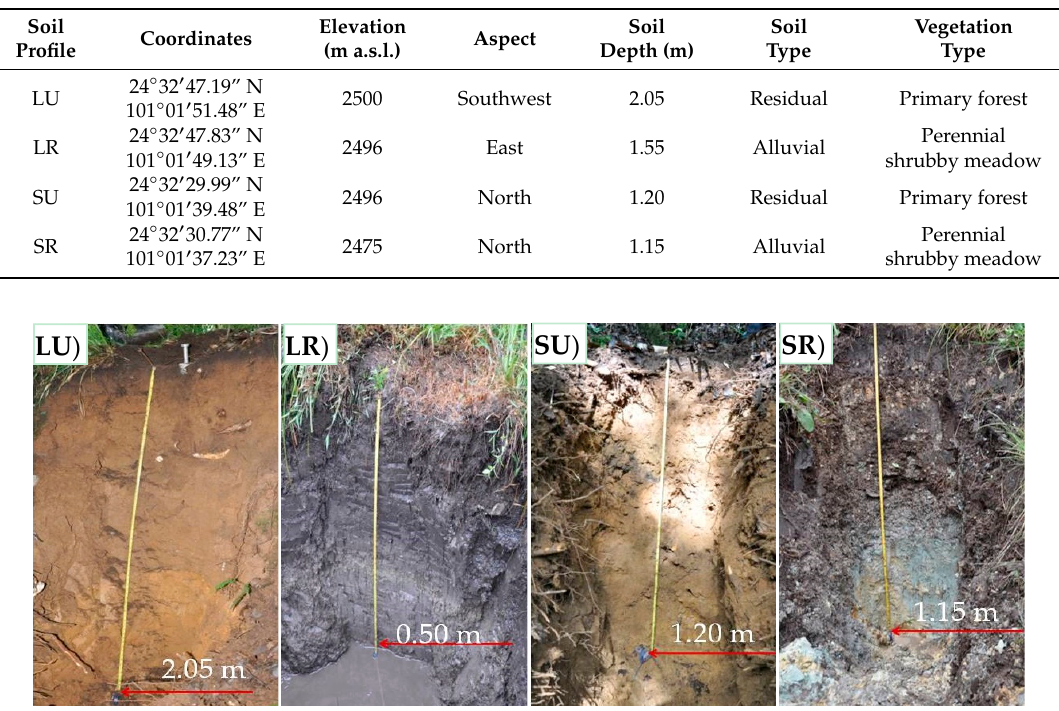
Table 1. Information of the four soil profiles (LU, LR, SU and SR) in a montane subtropical moist forest of southwestern China.